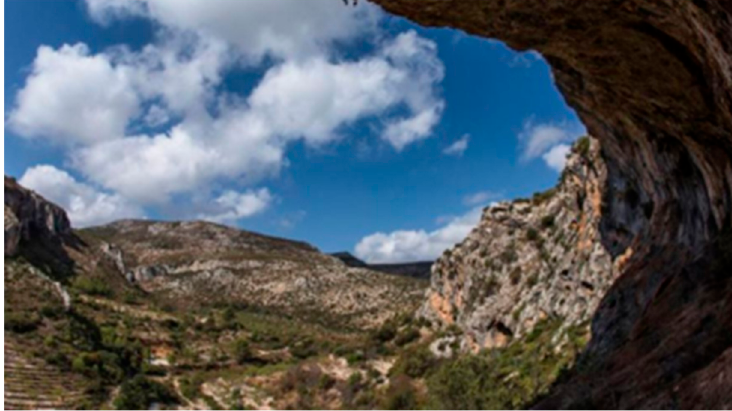
Figure 7. A circular territory can be seen from the prayer. Photo: Miguel Lorenzo.